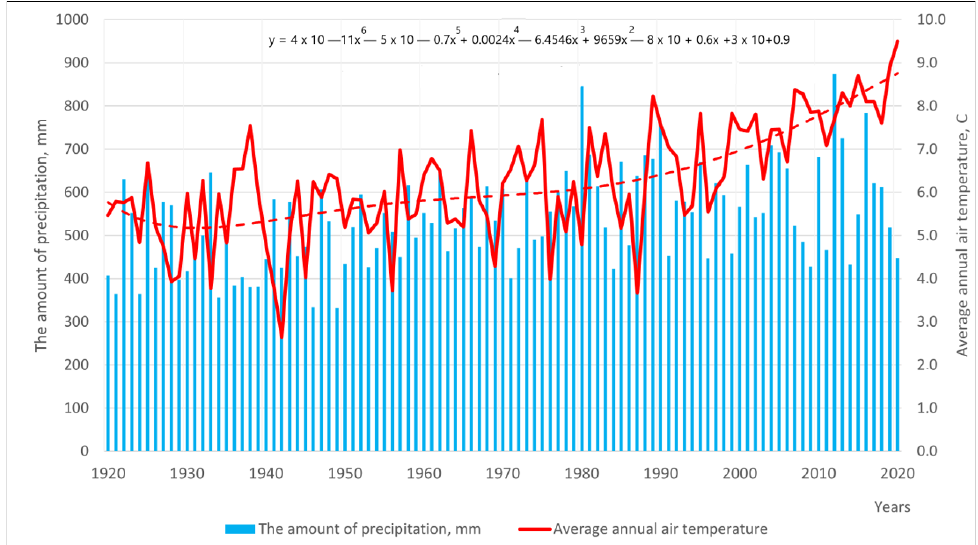
Figure 2. Precipitation and average annual air temperatures during the period of 1920–2020, according to the Shipov Forest Weather Station Krasny Cordon.